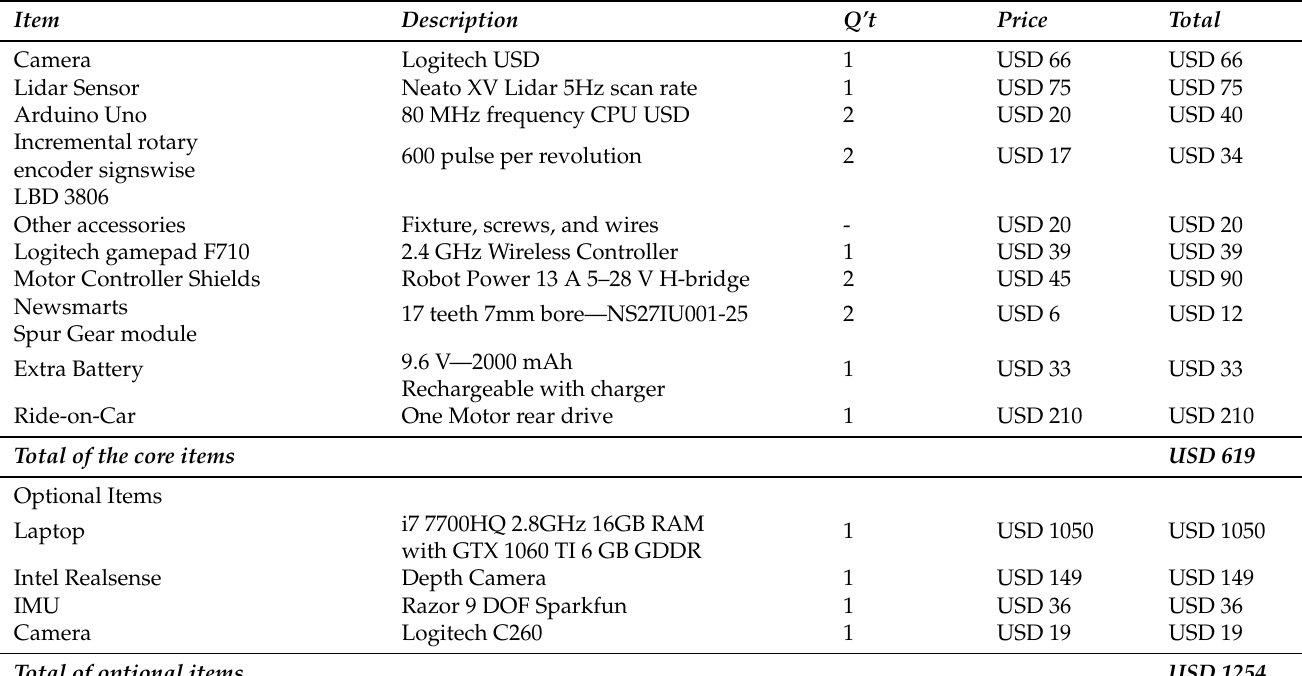
Table A1. Bill of